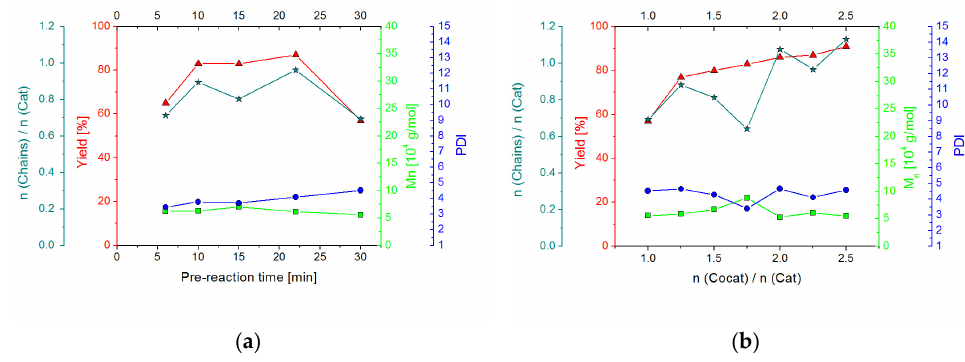
Figure 6. Overview on isoprene polymerization data obtained, when investigating the influence of pre ‐ reaction time (panel a ) and cocatalyst concentration ( b ), applying the catalytic system Nd(AlMe 4 ) 3 ( 2 Nd )/Et 2 AlCl ( E ) with a pre ‐ reaction time of 30 min as an example. The corresponding data are shown referring to four different y ‐ axes: red (yield), green ( M n ), blue (PDI) and teal (extrapolated ratio n(polymer chains)/n(Nd centers)). For details on the calculation of ratios n(chains)/n(Ln centers), see Section S3 of the Supplementary Materials. During these screenings, the microstructure remained constantly around cis / trans /3,4 = 98/0/2% (see Figure S1.4.1, Supplementary Materials). In both panels, lines are meant to assist the reader to follow the respective curves within the plot and not to indicate linear behavior of the curves in between the points of measurement.